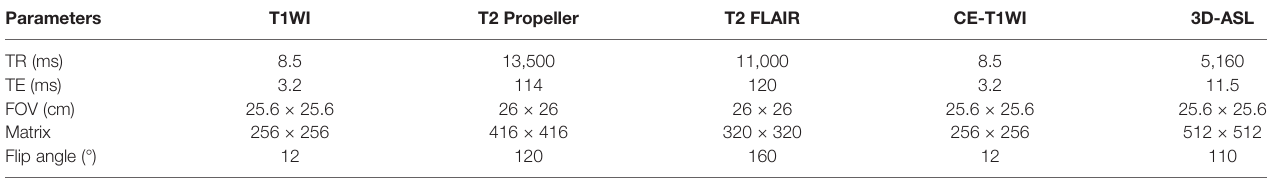
TABLE 2 | The common parameters of MRI sequences.